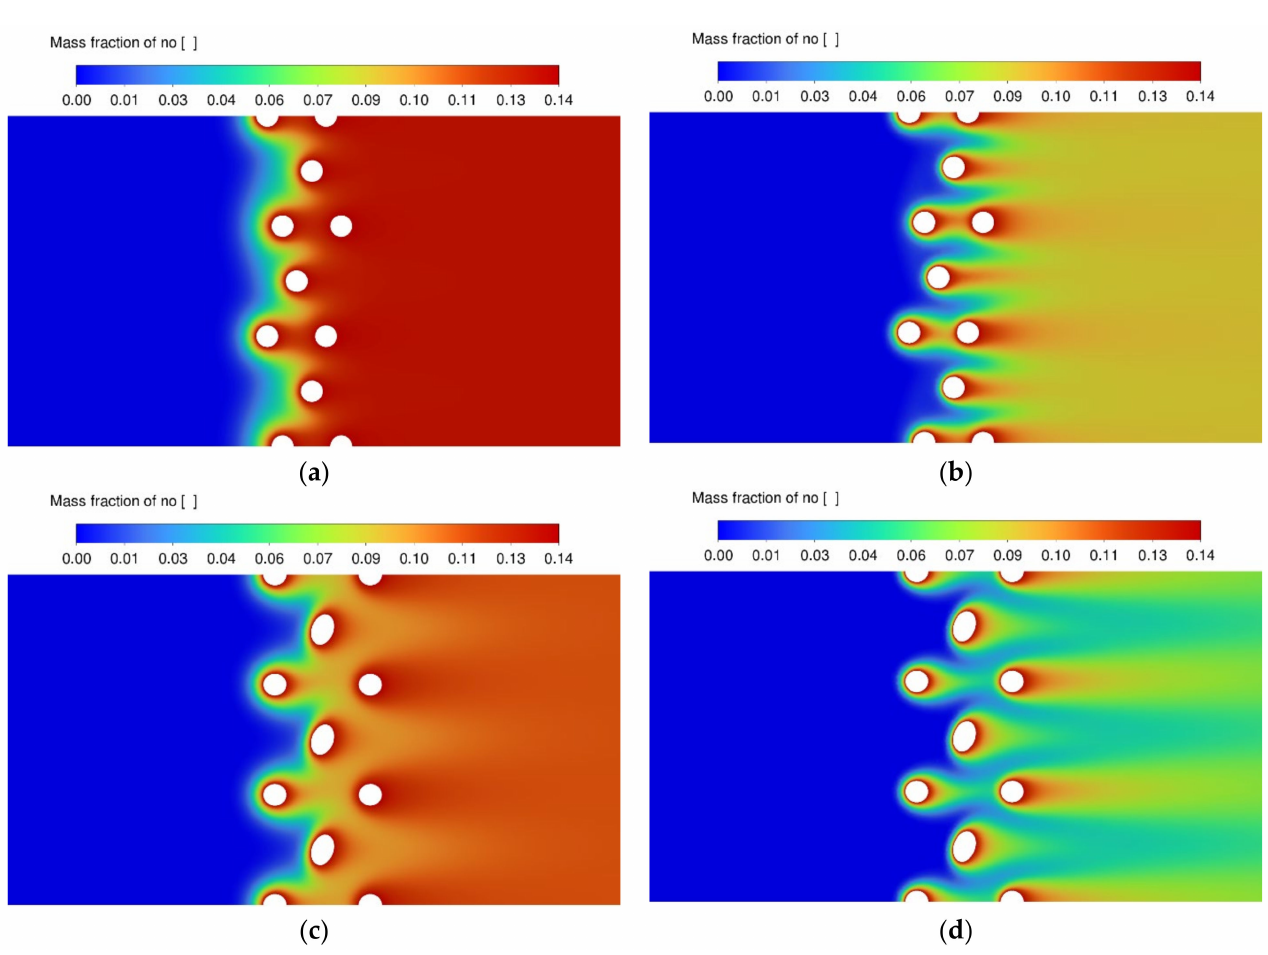
Figure 9. NO mass fraction contours for: ( a ) Geometry A, contact time of 0.001 s; ( b ) Geometry A, contact time of 0.00025 s; ( c ) Geometry B, contact time of 0.001 s; ( d ) Geometry B, contact time of 0.00025